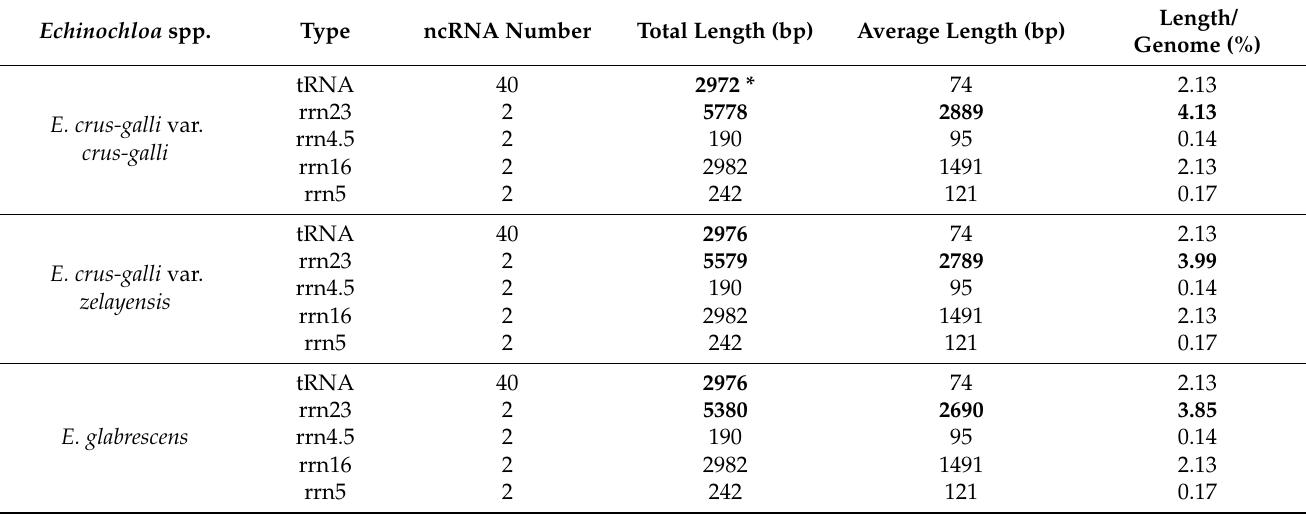
Table 3. Non-coding RNA statistics.